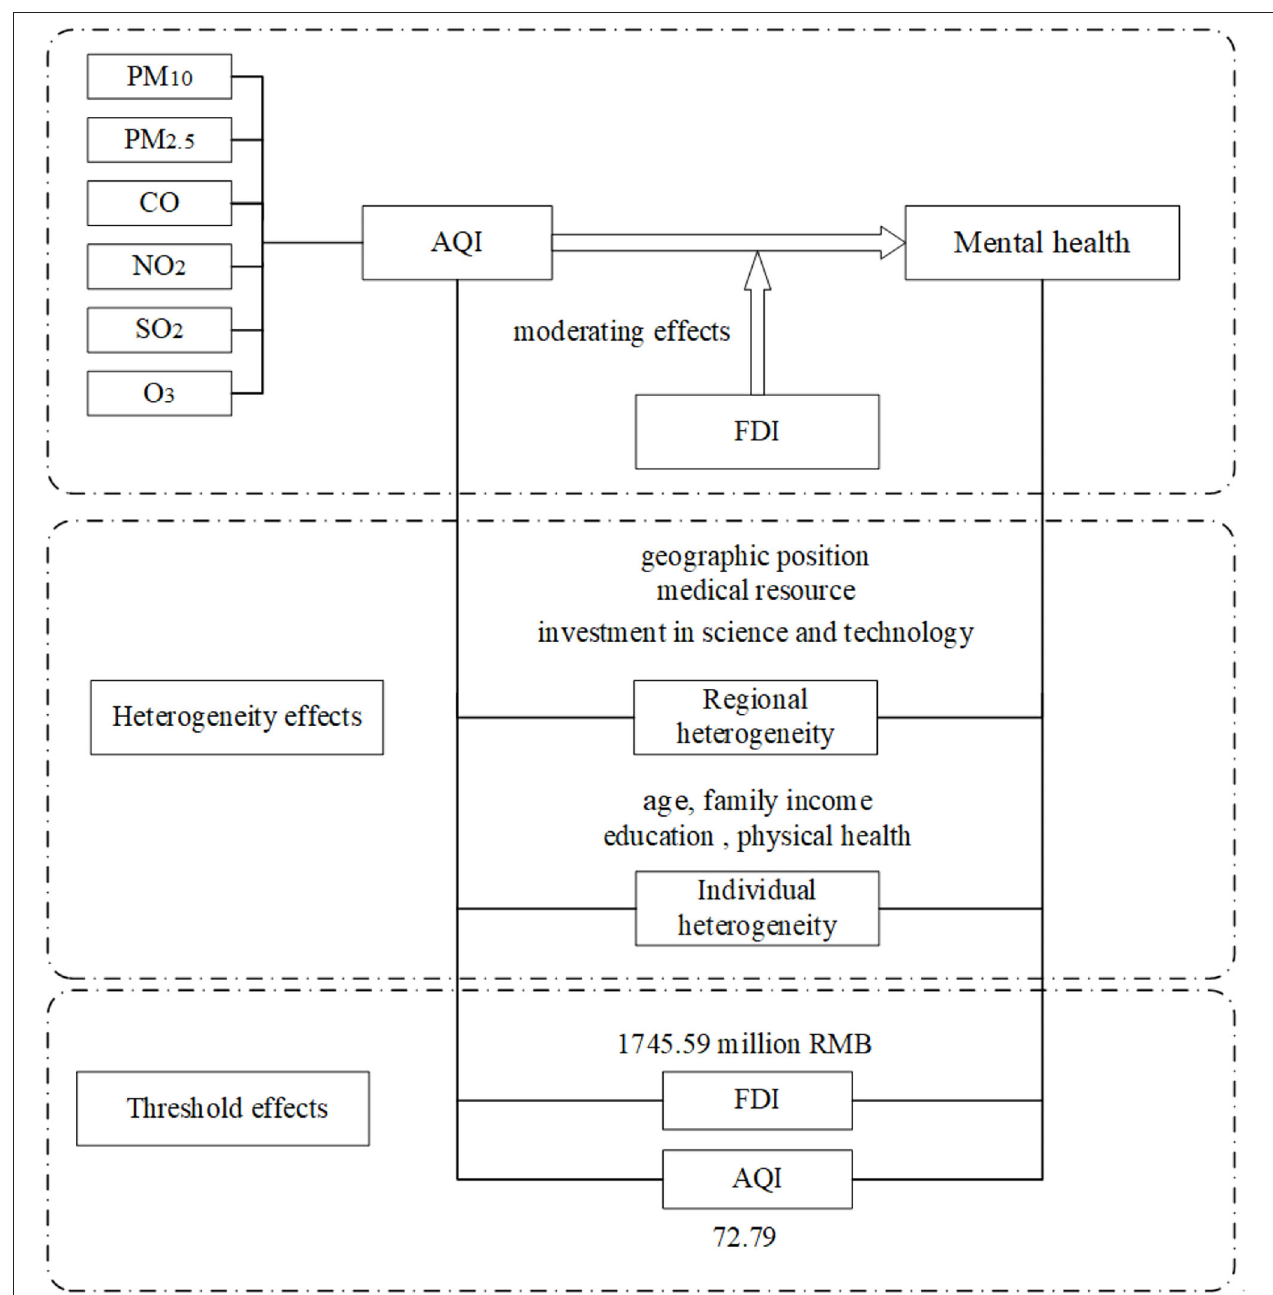
FIGURE 1 | Detailed process of the study.